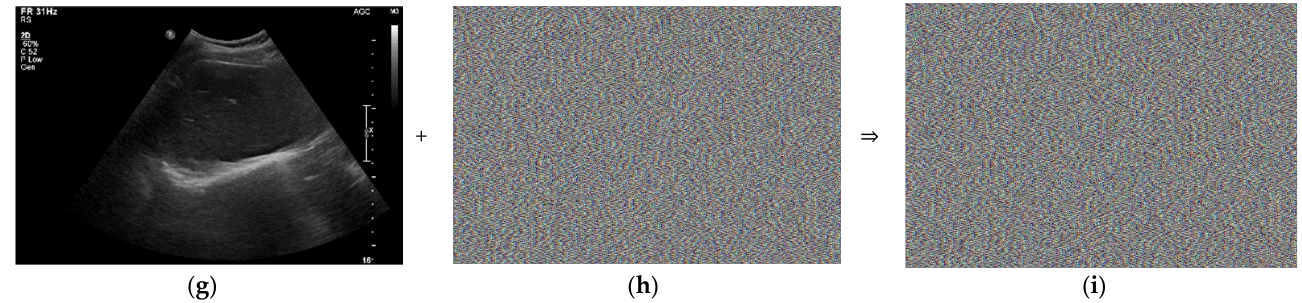
Figure 4. Randomized ultrasound abdomen phantom images: ( a ) ultrasound image; ( b ) 1000 × 663 random-bit generation visualization image; ( c ) randomized ultrasound image at dt = 0.5 μ s; ( d ) ultrasound image; ( e ) 1000 × 663 random-bit generation visualization image; ( f ) randomized ultrasound image at dt = 1 μ s; ( g ) ultrasound image; ( h ) 1000 × 663 random-bit generation visualization image; and ( i ) randomized ultrasound image at dt = 5.0 μ s.